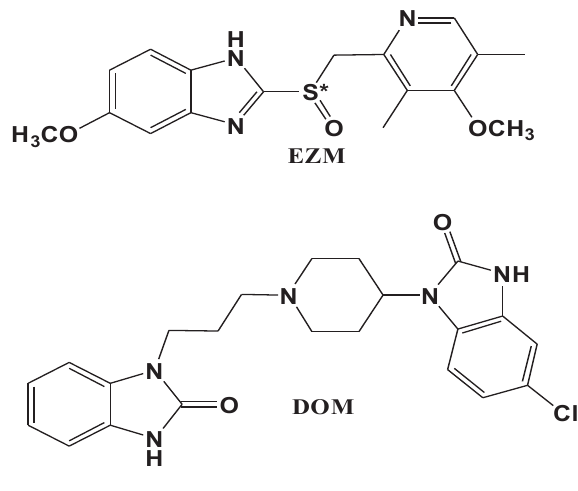
Figure 1: Drug structures.